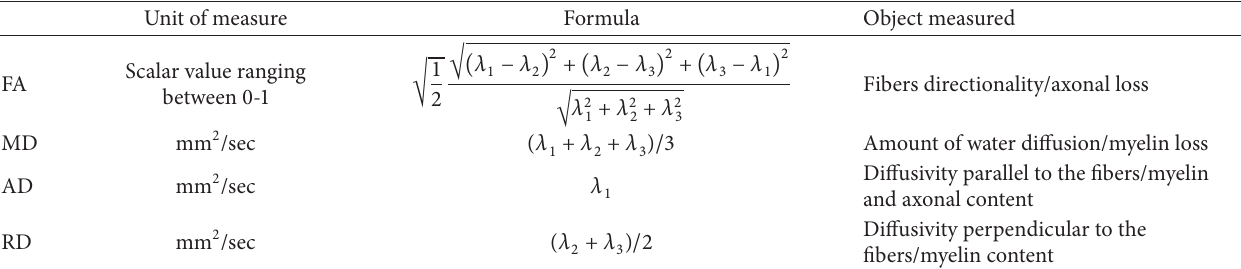
Table 1: Schematic description of the main DTI parameters.